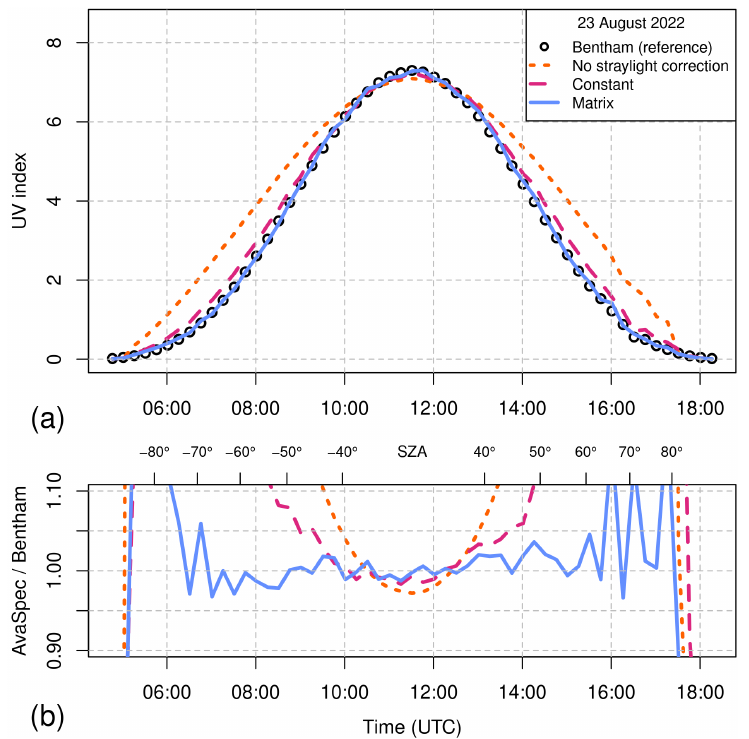
Figure 6. ( a ) Evolution of the UV index on 23 August 2022 (P1). The three coloured lines correspond to the AvaSpec measurements with three straylight corrections, while the dots represent the UV index from the Bentham (reference). ( b ) Ratio between the UV index from the AvaSpec and from the Bentham, as a function of time of the day and solar zenith angle (SZA, upper axis; negative values referring to morning, positive to